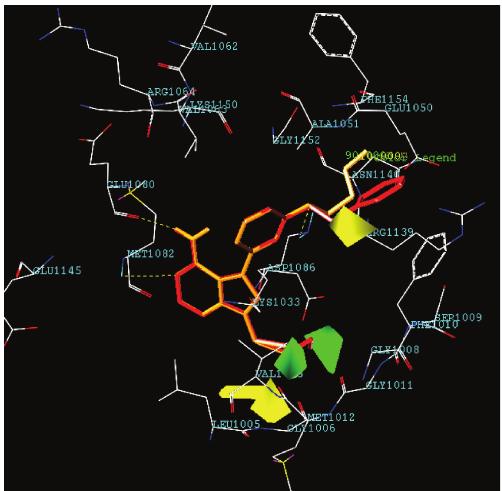
Figure 5: CoMSIA steric maps with the most (red) and least (or- ange) active compound within the active site.